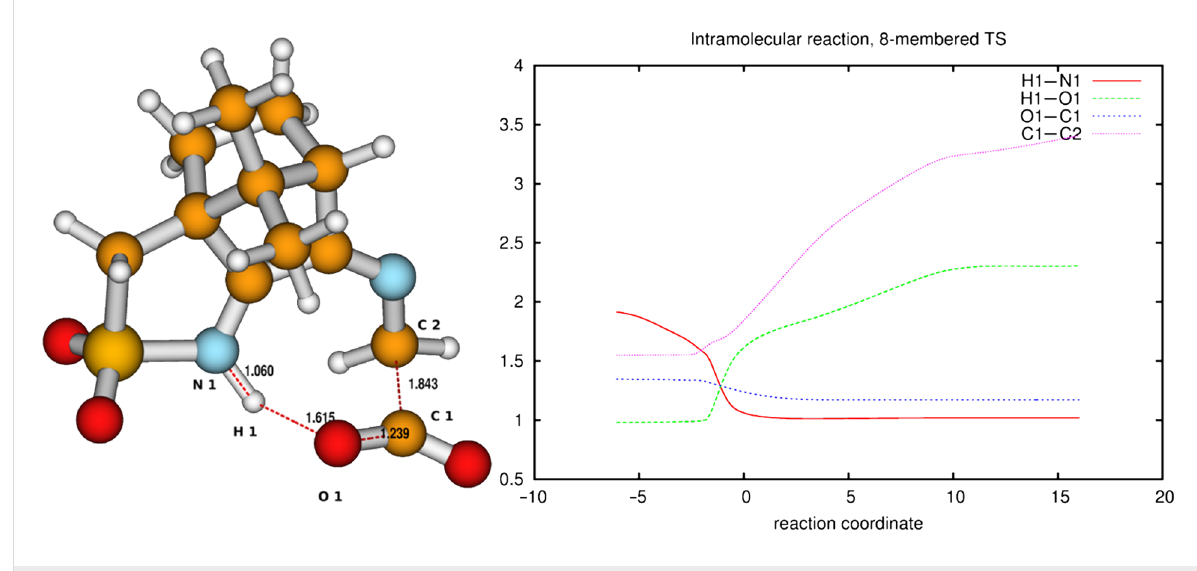
Figure 10: Transition-state geometry and salient bond distances along the IRC path for the reaction of 6g → 8 . The mass-weighted intrinsic reaction coordinate is in the unit amu ½ *bohr.